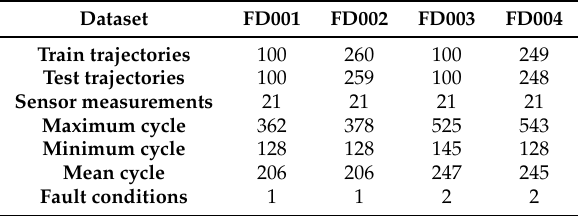
Table 1. Information on the C-MAPSS